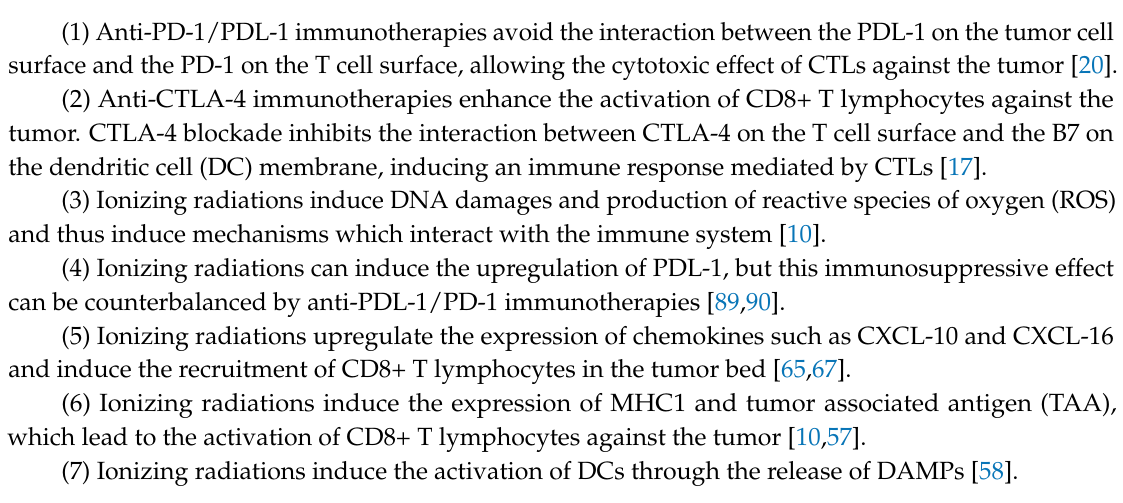
Figure 2. Ionizing radiations and immune checkpoint inhibitors synergize to enhance an antitumor immune response mediated by specific activated CD8+ T lymphocytes against tumor antigens (CTLs). [Arrows represent the activation or the mechanisms induced by radiation (orange), and cytotoxicity (blue). T bars (red) represent the inhibition processes of immune check point inhibitors.]